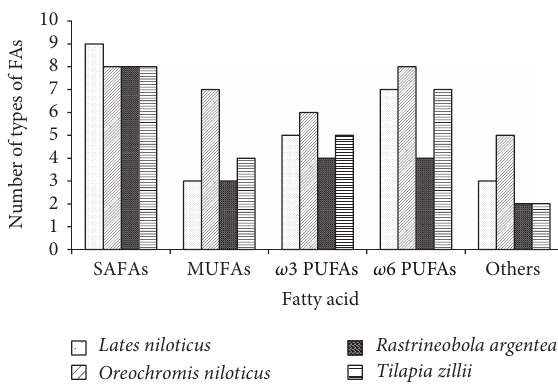
Figure 1: Types of FAs in each of the four commercial fish species studied.